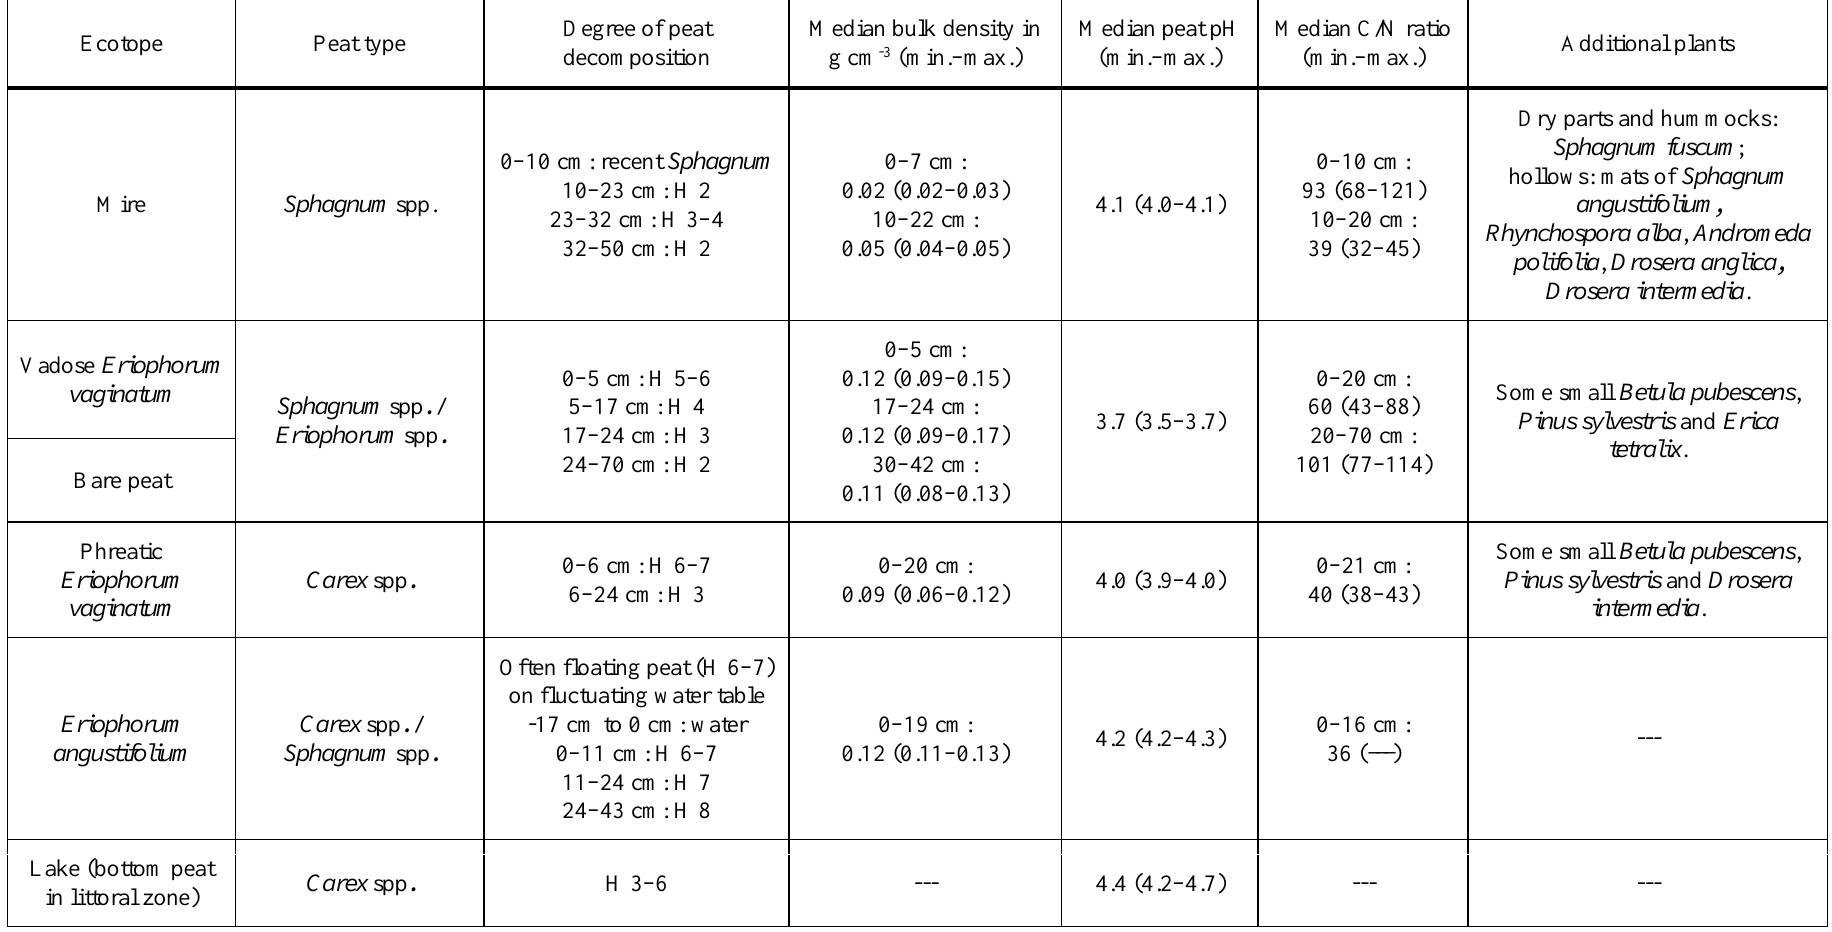
Table 2. Ecotopes (excluding pond) with main soil characteristics at different profile depths. H = degree of peat decomposition according to von Post (1924). Ecotope Peat type